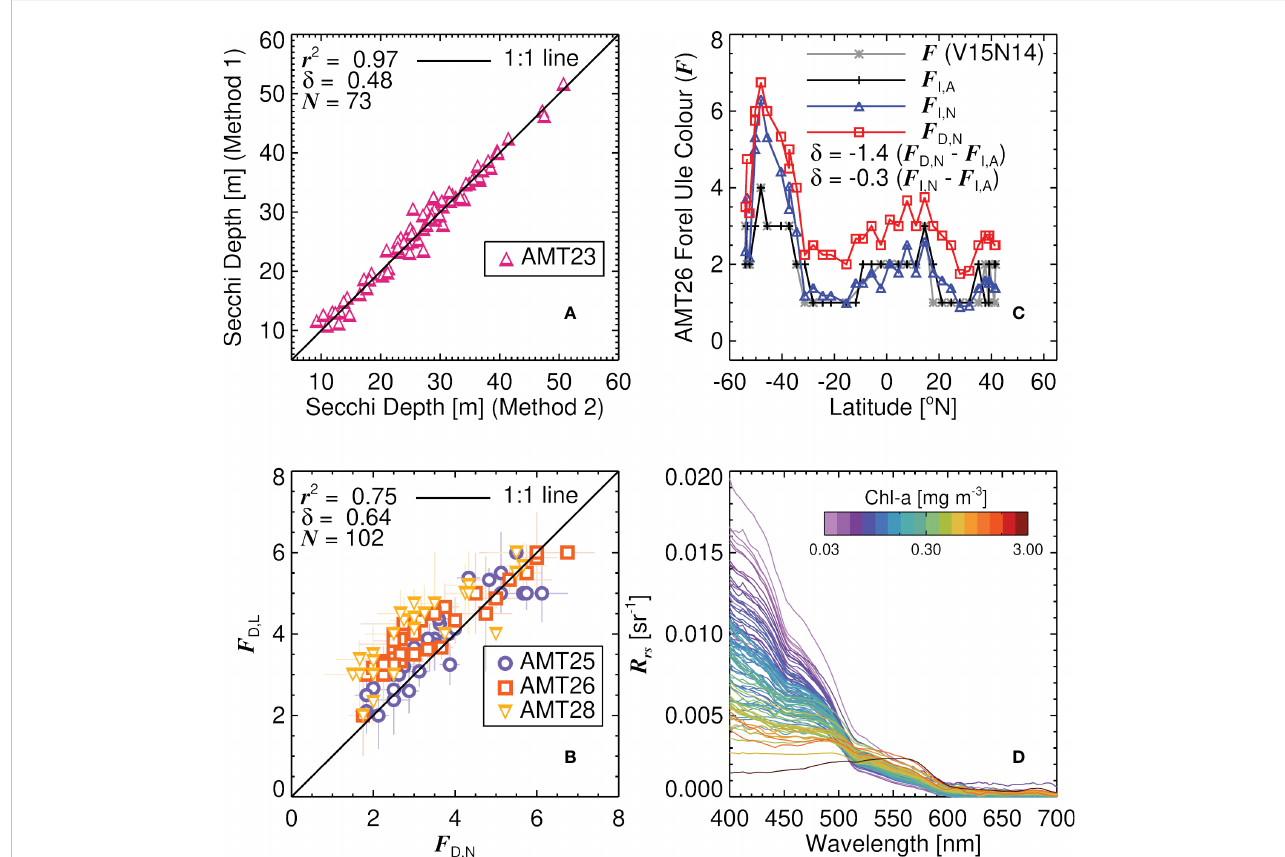
FIGURE 3 (A) Comparison between two methods for measuring the Secchi depth on AMT23. Method 1 involved linear interpolation, logging the time when the disk was at the surface, when it disappeared (or reappeared), and when the 50 m, 100 m and 150 m tags on wire were at the surface. Method 2 involved using a watch which was calibrated to the same time of a pressure sensor (CTD) on the pro fi ling rig, and logging the time of disappearance and reappearance (see Section 4.3.2 for further details). Note that data are shown for all the reappearances and disappearances logged (hence there are more samples ( N ) than stations on AMT23). (B) Comparison between the Forel-Ule colour ( F) using the method of Novoa et al. (2014) ( F D,N ) and the LaMotte method ( F D,L ), for the colour of the disk at half the Secchi depth on AMT25, AMT26 and AMT28. (C) AMT26 latitudinal transects of F using the method of Novoa et al. (2014), for the colour of the disk at half the Secchi depth ( F D,N ), for the colour of the disk at half the Secchi depth but converted to in fi nite colour using the method of Pitarch (2017) ( F I,N ), the Forel-Ule colour of in fi nite water measured using the EyeOnWater-Colour mobile phone app (Busch et al., 2016) ( F I,A ), and estimated F from R rs using the methods of van der Woerd and Wernand (2015) and Novoa et al. (2014) (V15N14). (D) Remote sensing re fl ectance data used in the study (101 stations) plotted as a function of wavelength and coloured according to the Chl-a concentration at the station. r 2 is the squared Pearson correlation coef fi cient, d the mean difference (bias) and N the number of